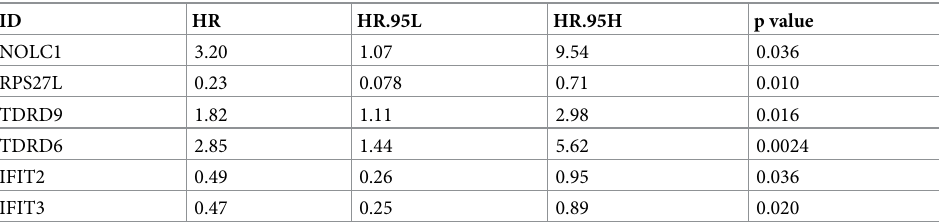
Table 1. Univariate Cox regression analysis